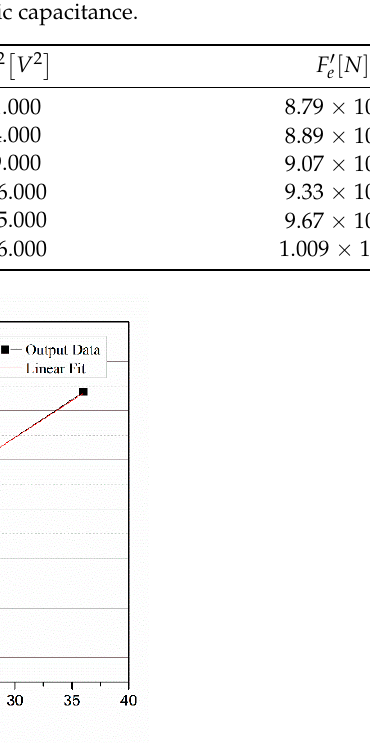
Table 3. Tested data of measuring mechanical